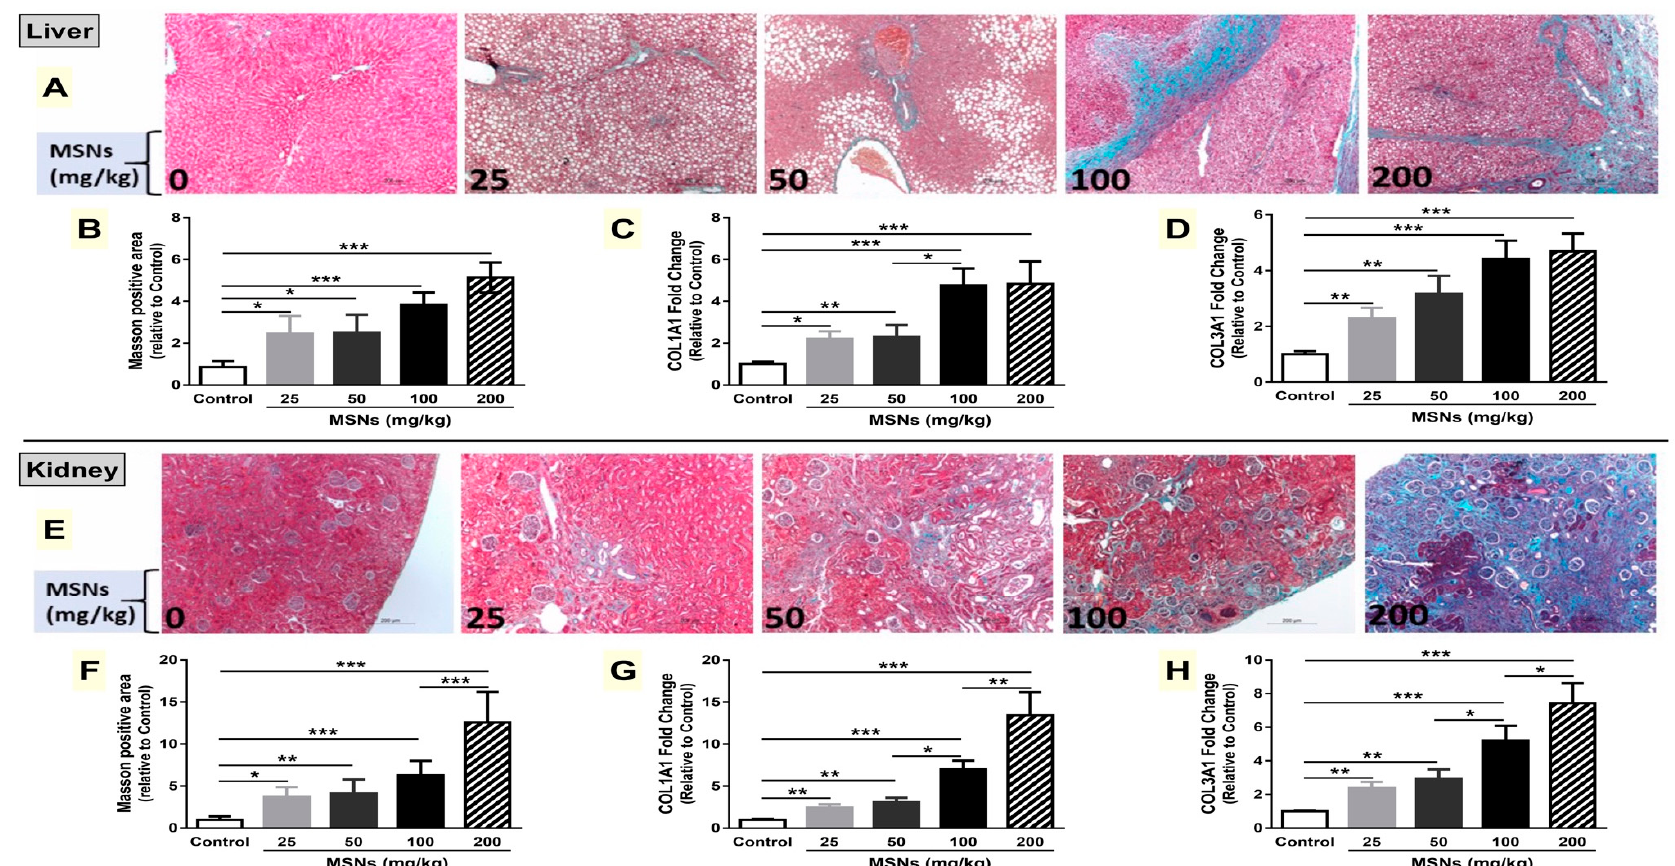
Figure 6. MSNs induce liver and kidney fibrosis in rats. ( A , E ) Photomicrographs of Masson’s trichrome-stained liver ( A ) and kidney ( E ) (X100). MSNs induced a significant increase in the deposition of collagen ( B , F ) and expression of collagen I ( C , G ) and collagen III ( D , H ) in the liver and kidney. Data are mean ± SEM ( n = 6). * p < 0.05, ** p < 0.01, and *** p < 0.001.